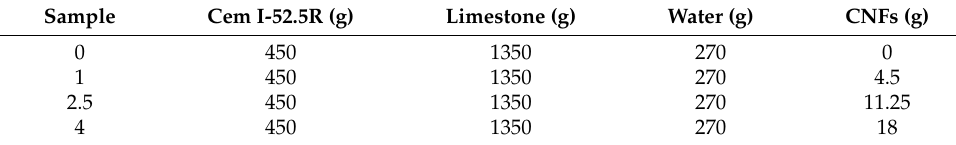
Table 1. Mixture design of electrical conductive